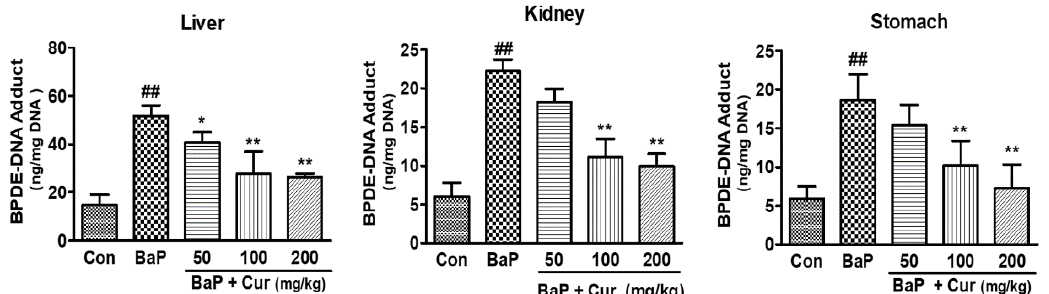
Figure 6. Effect of curcumin on the BPDE-DNA adducts formation in the target organs of Sprague-Dawley rats treated with benzo[a]pyrene (BaP) . Rats were orally administrated BaP alone (20 mg/kg) or in combination with curcumin (50, 100, or 200 mg/kg) for 30 days. The control group was administered vehicle only. Values are indicated by mean ± SD of six animals. Significant difference from the control group at ## p < 0.01; Significant difference from the BaP alone group at * p < 0.05; Significant difference from the BaP alone group at ** p < 0.01. Cur: curcumin.